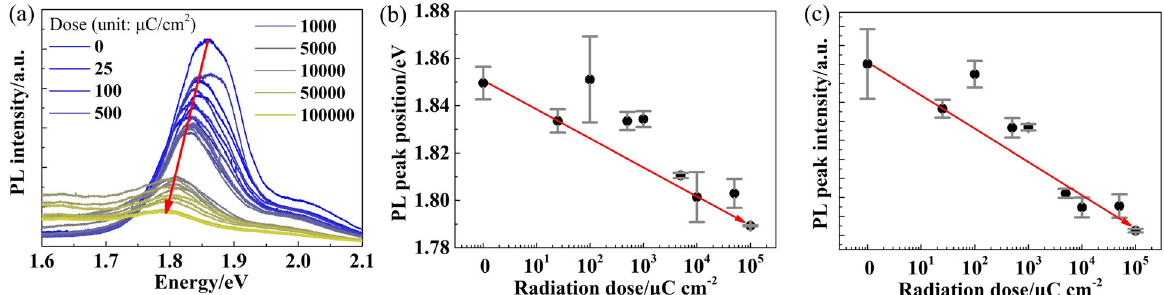
Fig. 2 Photoluminescence (PL) spectra analysis of the irradiation effect on monolayer MoS 2 . a The PL spectra of monolayer MoS 2 with different radiation doses up to 10 5 μ C/cm 2 . The peak for unirradiated sample at ~1.85 eV is consistent with previous reports for monolayer MoS 2 . b The relationship between PL peak position and radiation dose. A red shift can be observed as dose increases. c The relationship between PL peak intensity and radiation dose. A decrease of peak intensity can be observed as dose increases. These suggest sulfur vacancies are introduced to the MoS 2 fi lm after irradiation. The PL spectra are measured on three different locations for each dose to compensate for variation from material Raman peak positions, the E 2g peak and A 1g peak are observed to be red-shifted with increasing dose, as shown in Supplementary Fig. 3. The E 2g peak red shifts as restoring force constant of in- plane vibrations ( E 2g ) are weaken due to breakage of Mo – S bonds and generation of sulfur vacancies 69,70 . Supplementary Fig. 4